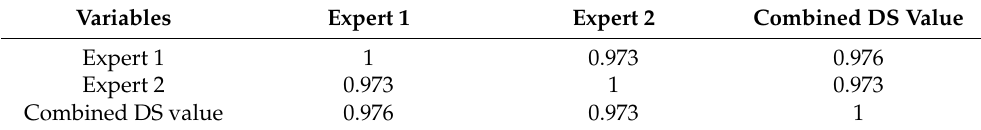
Table 13. Correlation matrix.